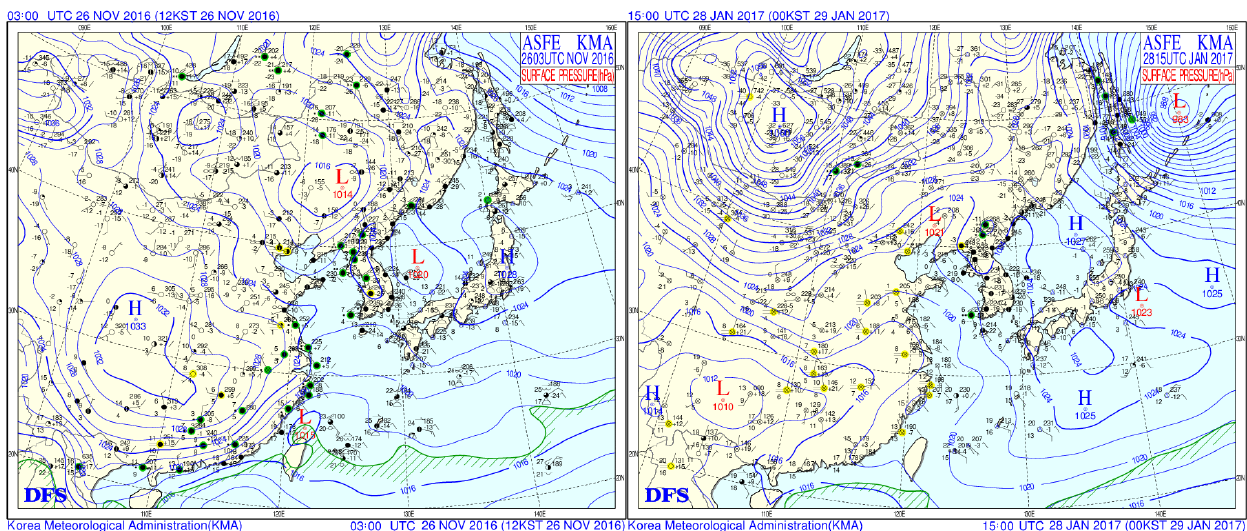
Figure 4. Typical surface weather conditions during CSs. Weather charts are from the Korea Meteorological